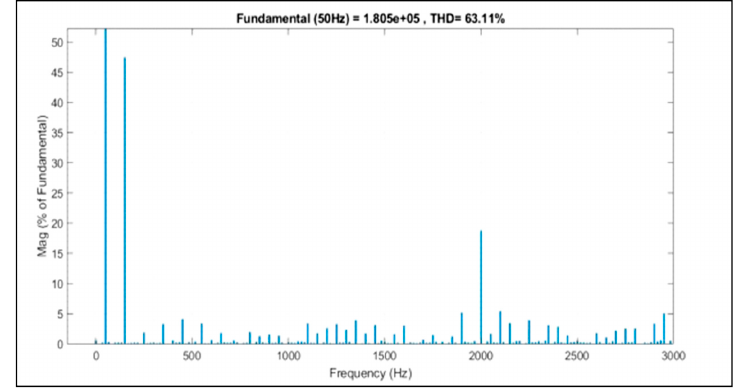
Figure 2. A representation of the harmonic component in the output voltage of the AC side cascaded configuration using two H-bridges [26].